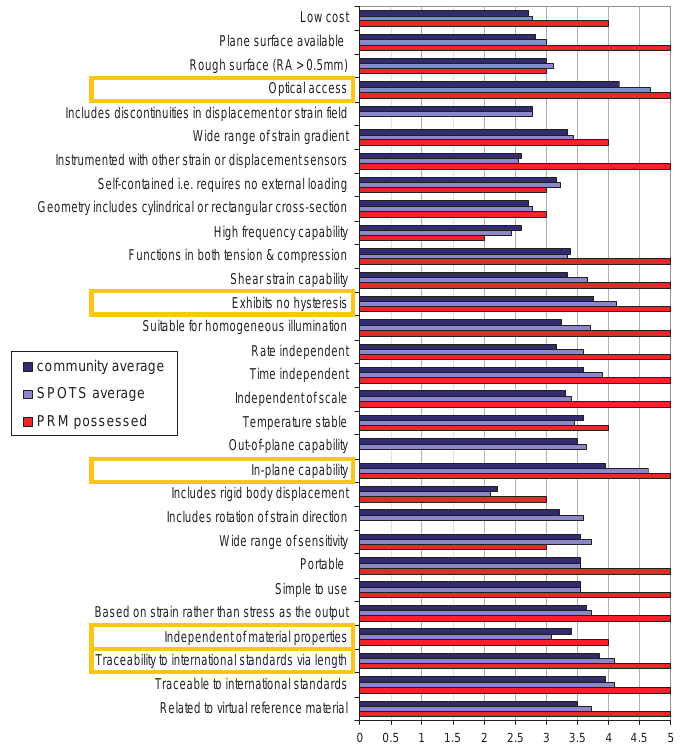
Fig. 1. Attributes and their weightings for the physical reference materials (PRM) together with the extent to which they are possessed by the selected PRM. The weightings (1 - unimportant, 2 - preferred, 3 - important, 4 - highly desirable, or 5 – essential) assigned by individual partners in the project were averaged and the same exercise repeated for the wider community including the SPOTS